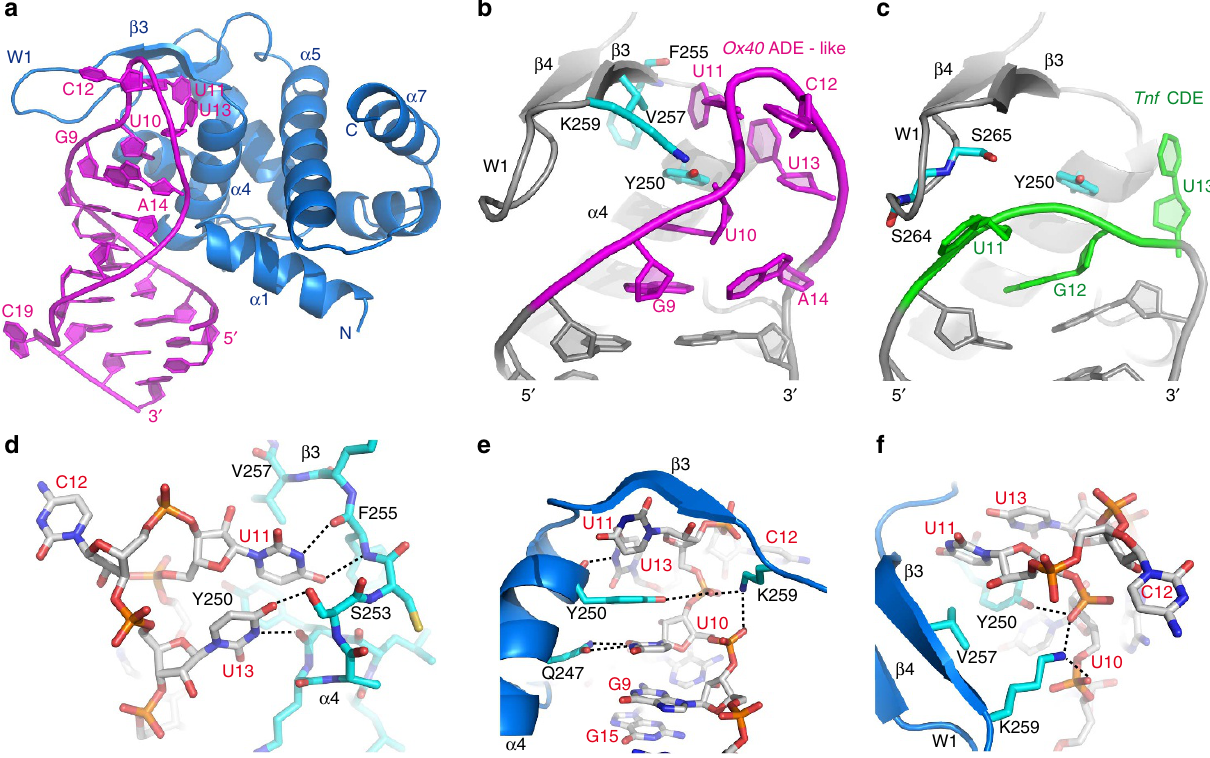
Figure 3 | Structure of the Roquin-1 ROQ domain bound to Ox40 ADE-like RNA. ( a ) Cartoon presentation of the crystal structure of the ROQ domain (residues 174–325; blue) and the Ox40 ADE-like SL RNA (magenta). Selected RNA bases and protein secondary structure elements are labelled. ( b ) Close-up view of the Ox40 ADE-like SL (bases in the RNA hexaloop are shown in magenta) and ( c ) the previously reported structure of the ROQ- Tnf CDE complex 11 (bases of the triloop RNA are shown in green). Only RNA-interacting residues that are different in both structures are shown. Both protein chains and remaining parts of both RNAs are shown in grey and protein residue side chains are shown in turquoise. ( d ) Close-up view of the contacts between the ROQ domain and nucleotides U11 and U13 of the Ox40 ADE-like SL RNA. The nucleotides interact with the C-terminal end of helix a 4 (Tyr250 and Ser253) and the N-terminal part of strand b 3 (Phe255 and Val257). The protein chain is shown in turquoise and the RNA is shown in grey. Atoms are colour coded according to charge. ( e ) Close-up view of the contacts between the ROQ domain and nucleotides U10, U11 and U13 in the RNA hexaloop. U11 and U13 contact the C-terminal end of helix a 4: residues Tyr250 and Gln247. The side chain of Tyr250 makes hydrophobic interactions with the pyrimidine side chain of U10 on one side and U11 on the other side. Lys259 interacts with the phosphate groups of U10 and U11. ( f ) Close-up view of the hydrophobic interaction between Val257 and U11, as well as the double hydrogen bond of Lys259 with phosphate groups of U10 and U11. In d – f , amino acids are shown in turquoise and blue, nucleotides in grey colour. See also Supplementary Notes and Supplementary Fig.